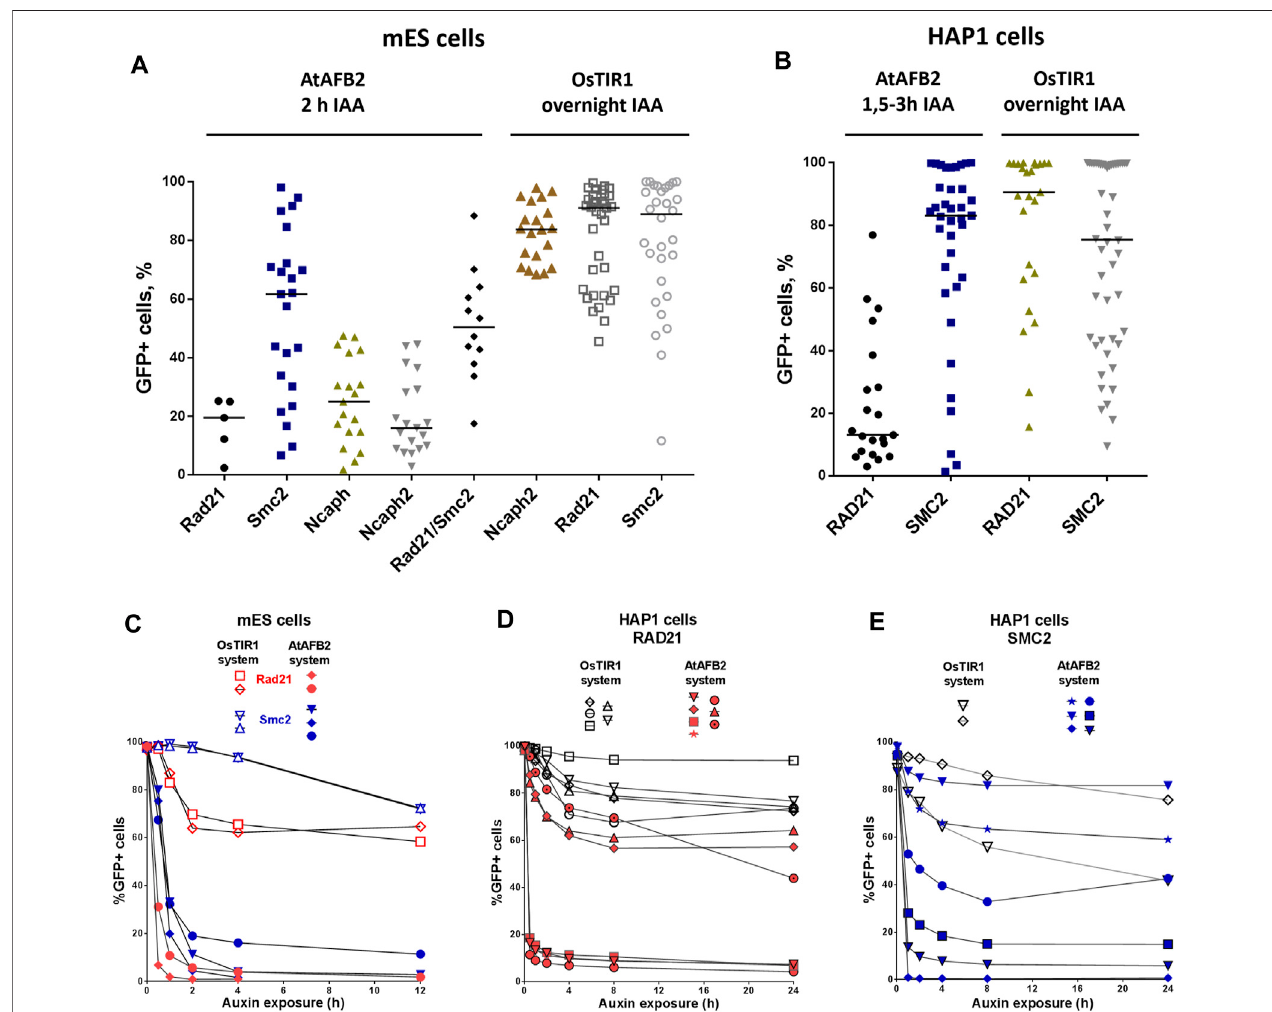
FIGURE 3 | Degradation ef fi ciency and dynamics of POI depletion in mESC and HAP1 clones with randomly integrated OsTIR1 and AtAFB2 constructs. POI degradation ef fi ciency in mESC clones (A) and HAP1 clones (B) . Each dot represents one independent cell clone derived after AFB protein gene integration. For each clone, the measurement was carried out once. The black horizontal line shows the median of the group. (C) POI degradation dynamics for selected mESC clones (Rad21-mAID-Clover, Smc2-mAID-Clover, Rad21-miniIAA7-eGFP, Smc2-miniIAA7-eGFP) with OsTIR1 and AtAFB2. For each clone, the experiment was carried outonce. (D) POIdegradationdynamicsforHAP1clones(RAD21-miniIAA7-eGFP,RAD21-mAID-Clover)withAtAFB2andOsTIR1.Foreachclone,theexperimentwas carried out once. (E) POI degradation dynamics for HAP1 clones (SMC2-miniIAA7-eGFP, SMC2-mAID-Clover) with AtAFB2 and OsTIR1. Numbers in brackets are individual clones ’ designations. For each clone, the experiment was carried out